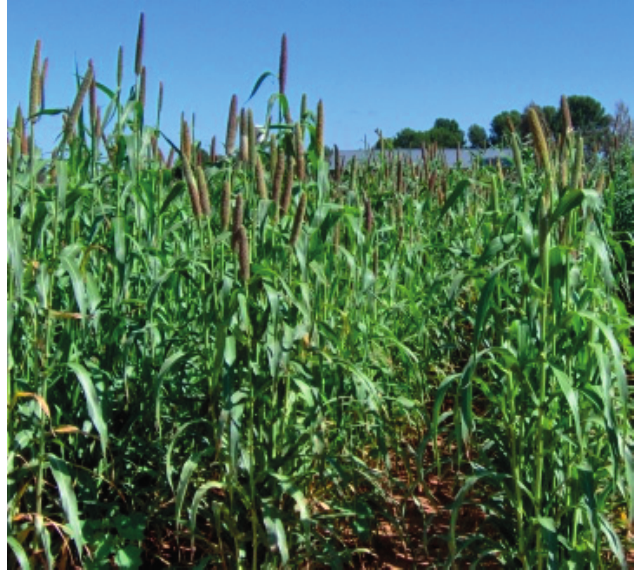
Figure 2. A crop of pearl millet. Source